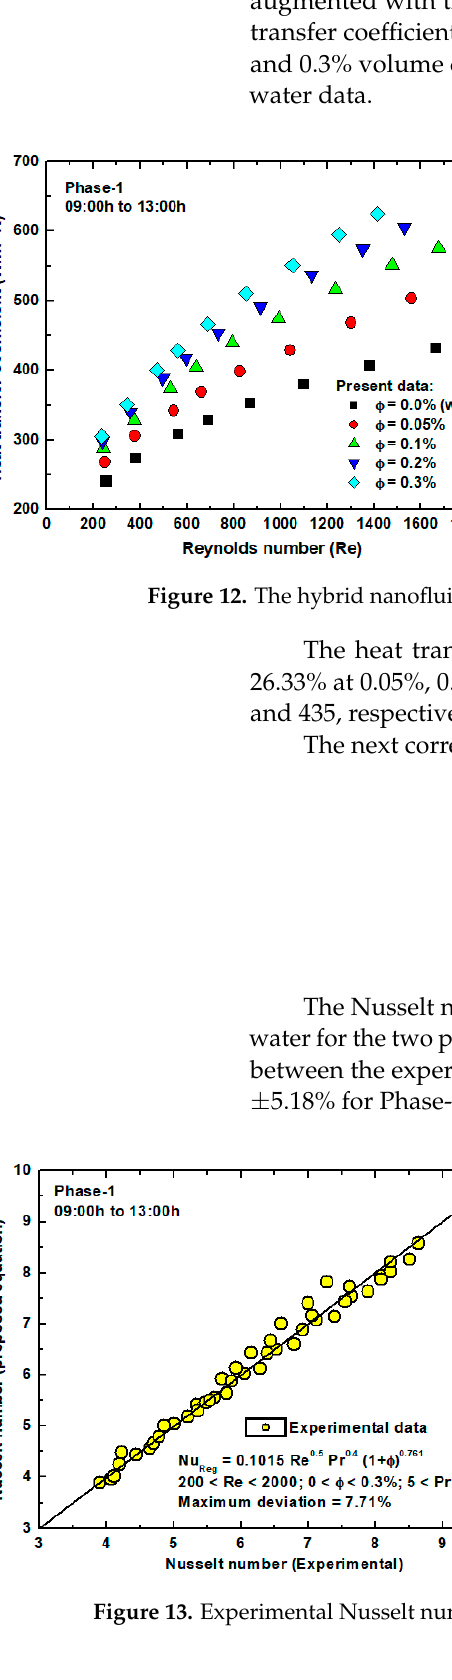
(20) The experimental friction factor in the case of water versus the calculated values by Equation (20) for Phase-1 and Phase-2 is displayed in Figure 14a,b. The deviations be- tween the experimental and calculated values are within ±2.5%. Figure 14. Experimental friction factor validation with literature values; Phase-1 ( a ), and Phase-2 ( b ). The friction factor of hybrid nanofluids at different Reynolds number in Phase-1 is illustrated in Figure 15a. The friction factor is increased with the increase of Re and volume concentration. The friction factor increases by 5.11%, 7.51%, 9.91%, and 11.51% at 0.05%, 0.1%, 0.2%, and 0.3% volume concentrations and Re of 248, 242, 238, and 235, re- spectively compared to water data. The friction factor is further increases by 7.65%, 11.8%, 14.46%, and 18.91% at 0.05%, 0.1%, 0.2%, and 0.3% volume concentrations and Re of 1774, 1674, 1528, and 1413, respectively, over water data.